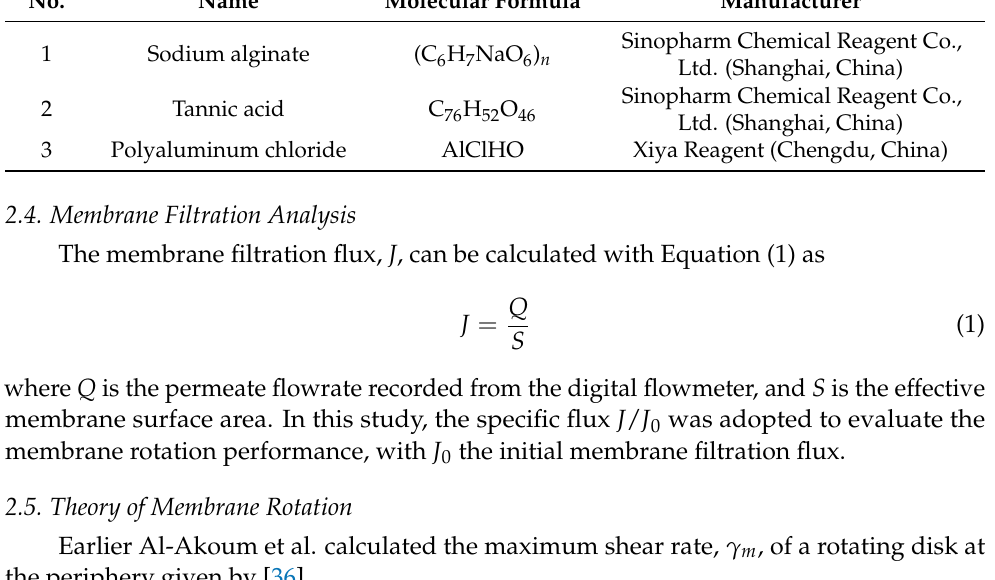
Figure 2. Molecular weight distribution of ( a ) sodium alginate and ( b ) tannic acid. Table 1. Product information of SA, TA, and PAC used in the present study.